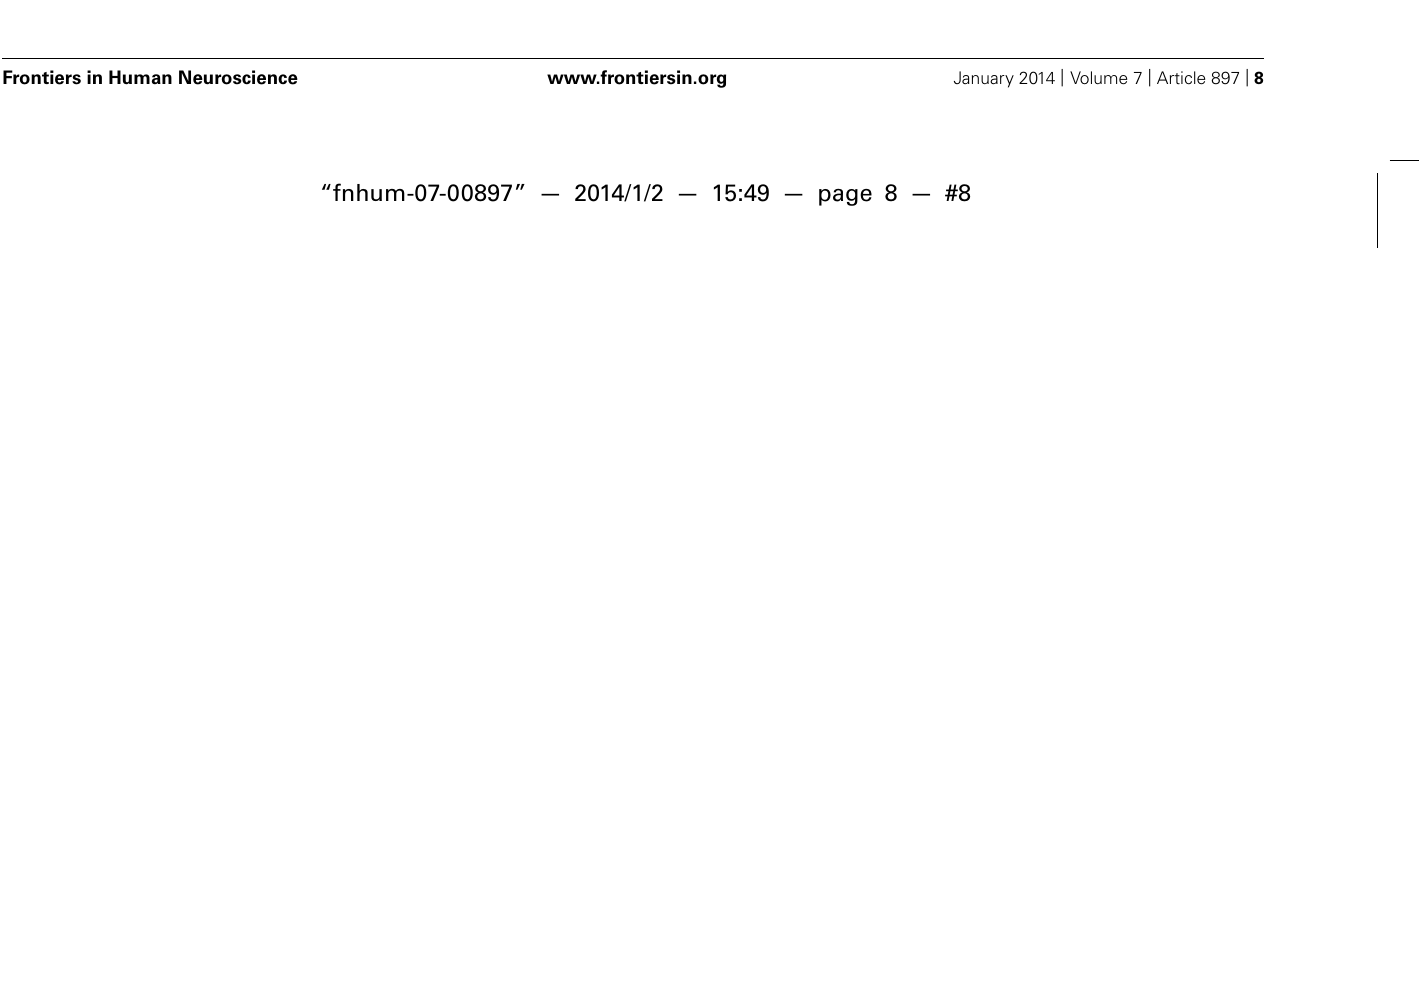
FIGURE 3 | Sustained Attention to Response Task (SART) performance overtime and between training groups on three outcome measures of the SART: (A) average overall accuracy, (B) average intra-individual reaction time variability, and (C) average response to